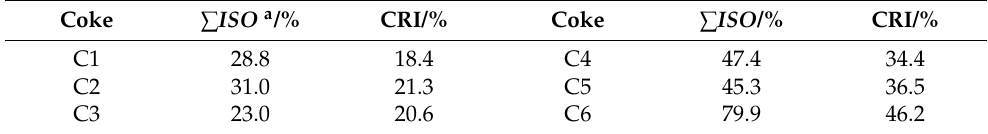
Table 7. The optical texture contents and CRI value [45].